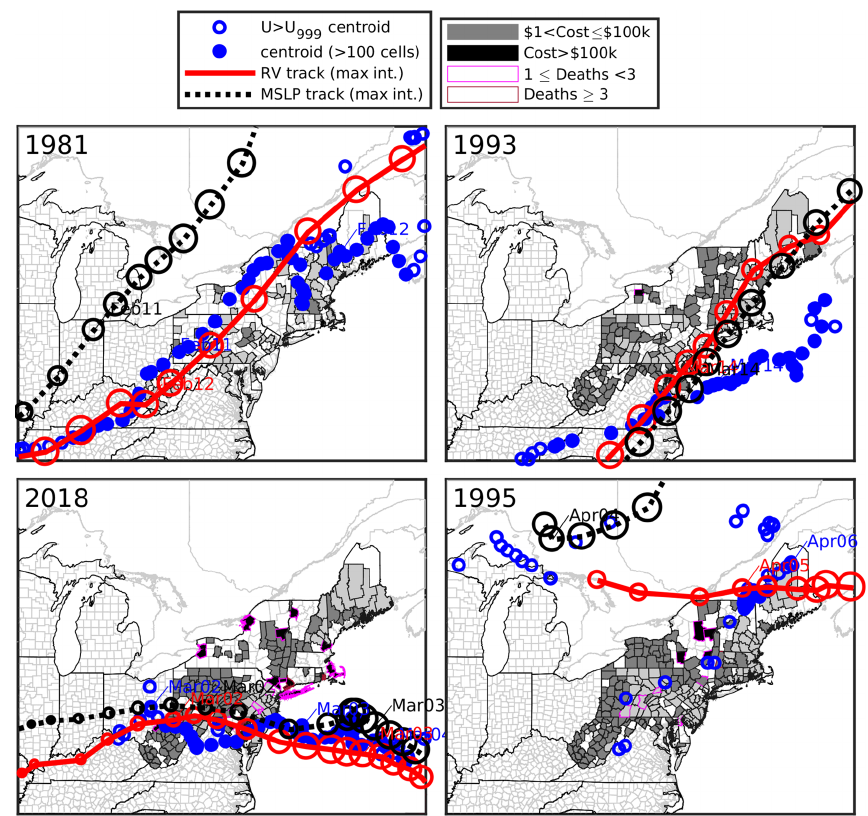
Figure 3. Centroids of the windstorms computed as the geographic center of all ERA5 grid cells for U>U 999 (blue). Markers are filled when there are > 100 cells over this threshold. Timing and location of the cyclone centers as diagnosed from MSLP and relative vorticity at 700hPa are shown in black and red, respectively. Markers every 3h along each track have a diameter corresponding to track intensity. The underlying shading shows the county-level damage and deaths in the northeastern states associated with each event as diagnosed from the NOAA storm